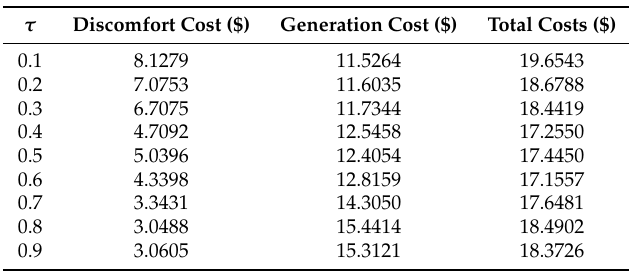
Table 3. The cost